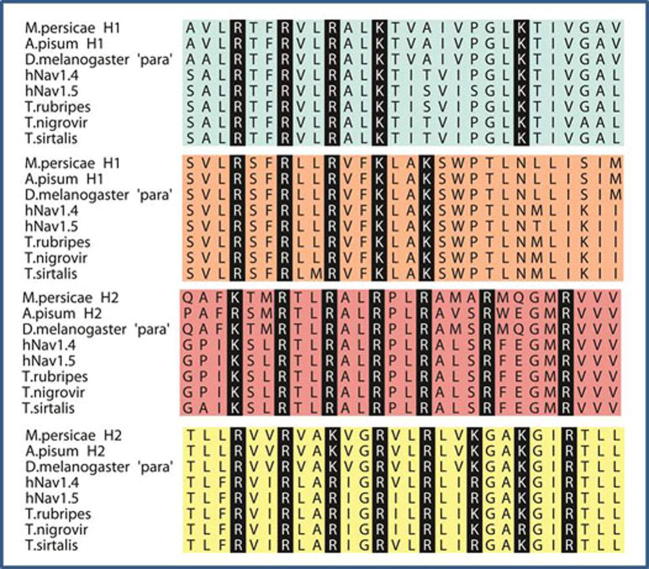
Alignment of S4 helices within Nav channel voltage sensing domains. Conserved positively-charged residues [black highlights] in the S4 helices in the voltage sensing domains of the H1 (cyan and orange) and H2 (pink and yellow) aphid subunits and the DI (cyan), DII (orange), DIII (pink) and DIV (yellow) segments, respectively, of the non-aphid polypeptides.